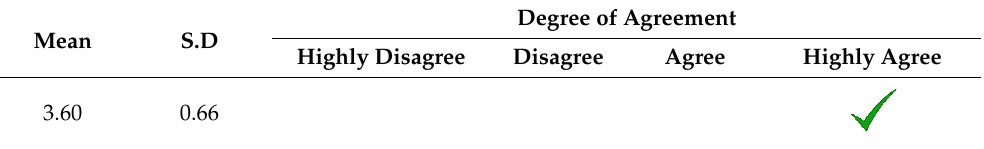
Table 3. Responses to Question 1-a. Table 5. Responses to Question 3-a.